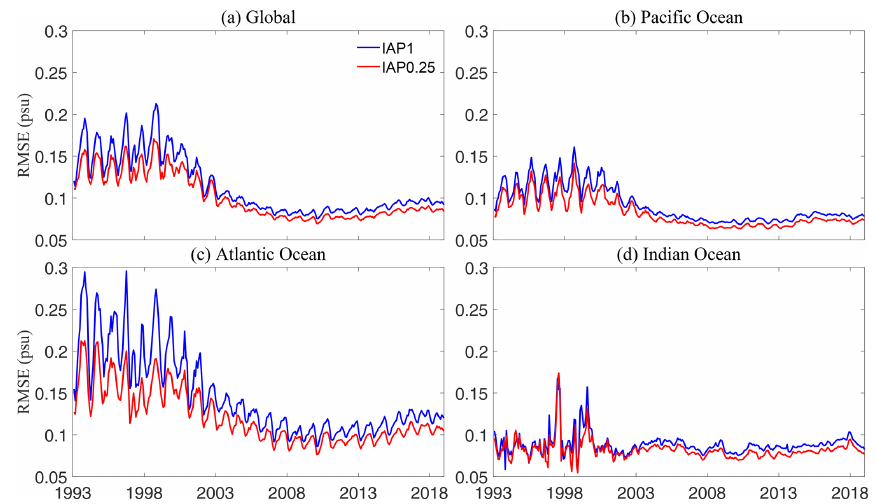
Figure 11. The 1–2000m average RMSE time series for the IAP0.25 ◦ and IAP1 ◦ datasets for the globe and three ocean basins from 1993 to 2018.